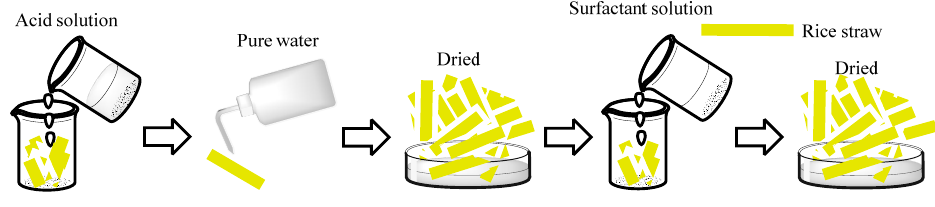
Figure 10. Modi fi cation of rice straw.